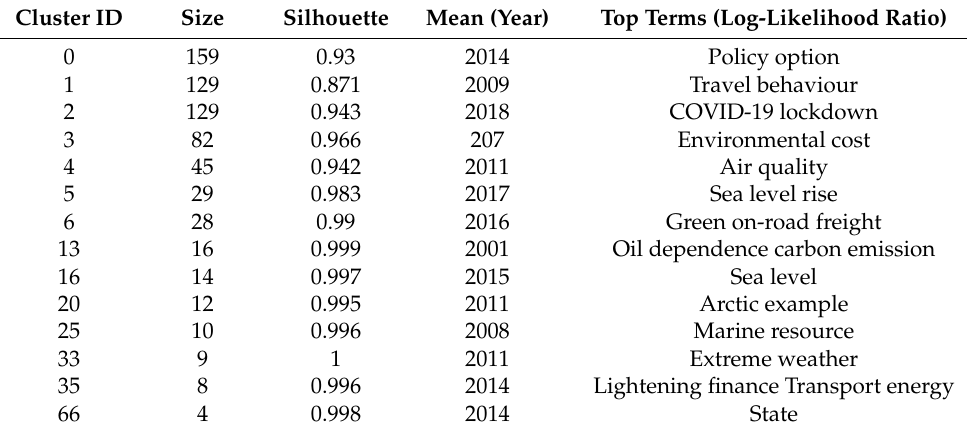
Table 7. Top 14 co-citation